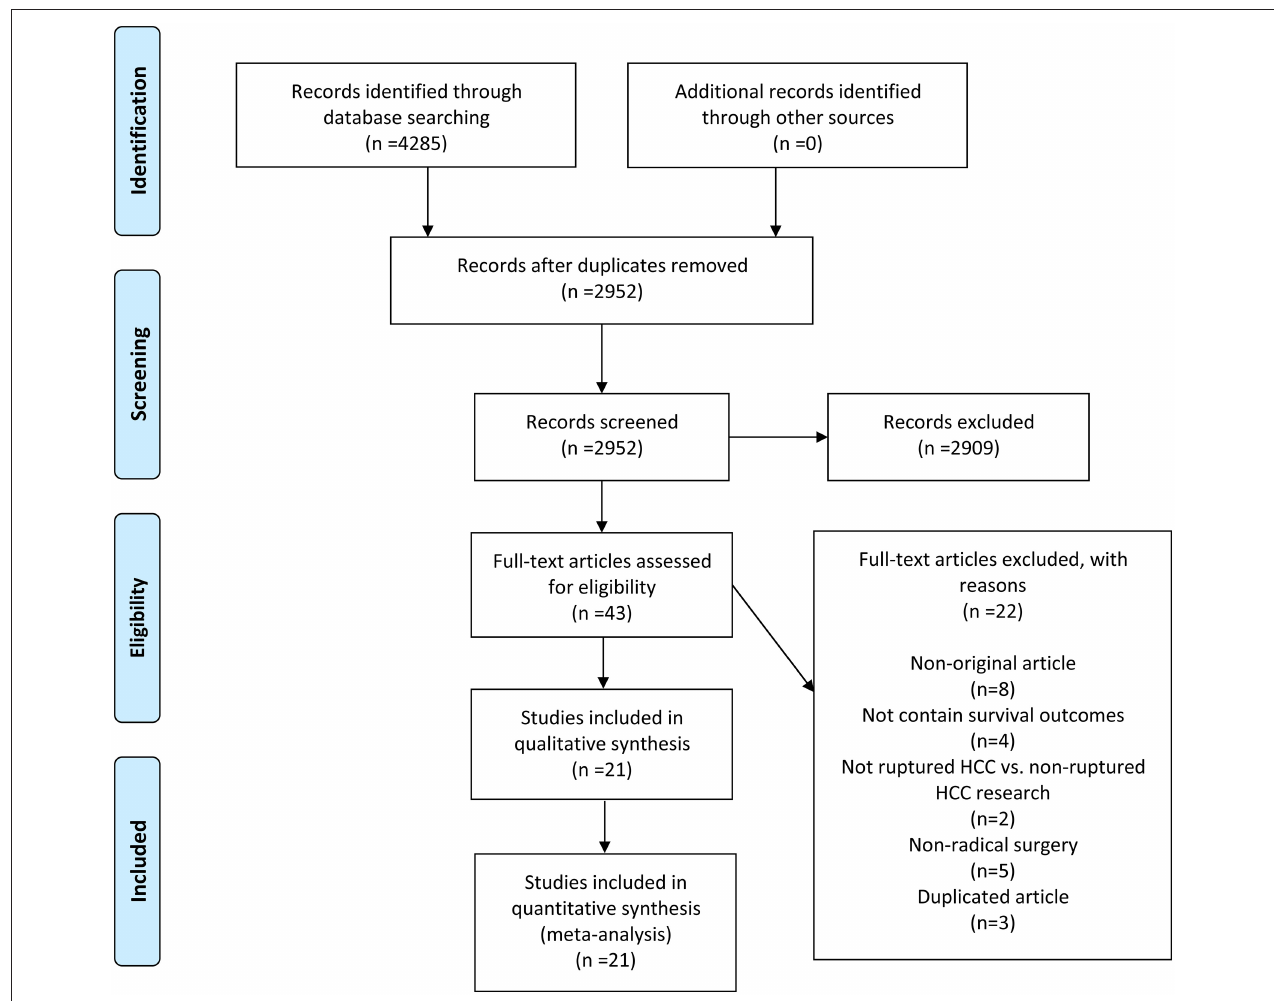
FIGURE 1 | A schematic flow for selecting the articles included in this